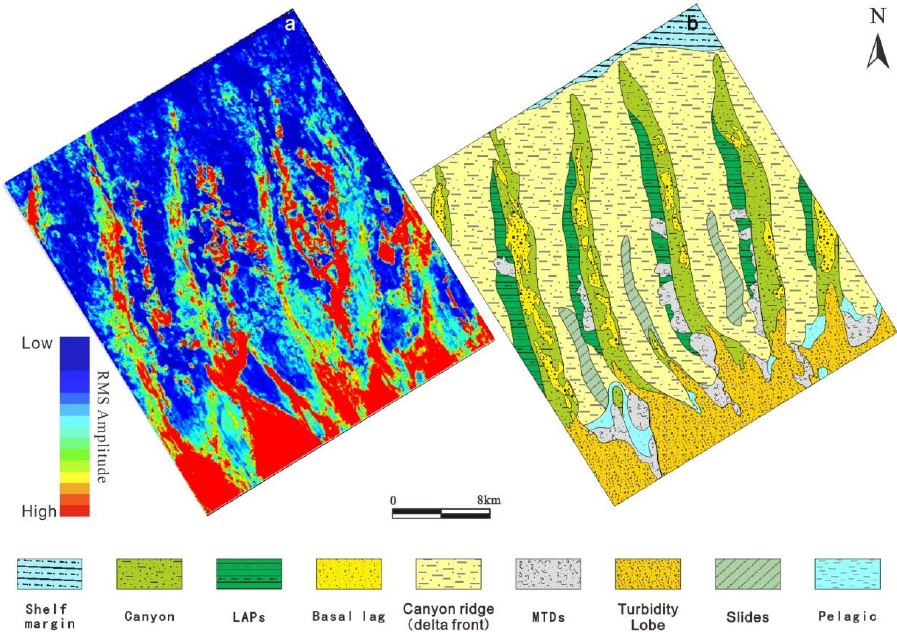
Figure 6. ( a ) RMS attribution of horizontal slice following T20; ( b ) Interpretation of depositional system in the Pliocene due to RMS attribution and typical seismic profiles.